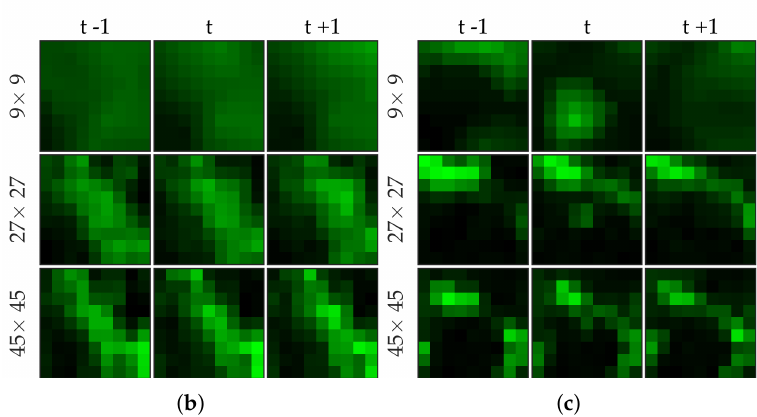
Figure 5. Illustration of spatio-temporal and multi-resolution feature extraction. ( a ) Image patches around positive (red) and negative (green) annotations: the three boxes are of sizes 9 × 9, 27 × 27 and 45 × 45 pixels respectively; ( b ) Features (neg. sample); ( c ) Features (pos. sample).